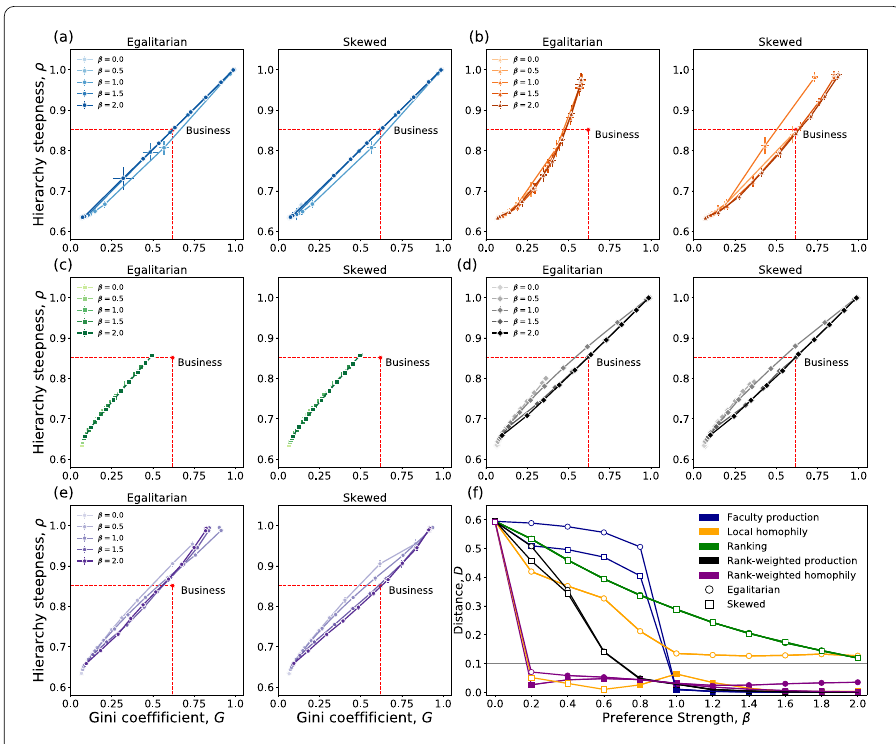
Figure 2 Structural inequalities of five hiring models vs. empirical faculty hiring network of Business departments. ( a )–( e ) Steady-state values of Gini coefficient G and hierarchy steepness ρ , for the five hiring models and two initial conditions for different choices of β (for simplicity, we only show β ∈ { 0.0,0.5,1.0,1.5,2.0 } ). Each line is a parametric plot in which we vary the randomness parameter over 0 ≤ p ≤ 1, and hence all models and choices of β converge to the same point in inequality-space as p → 1. Red dashed lines show the empirical values of G and ρ for the Business faculty hiring network. Results are averaged over 50 simulations, and error bars indicate standard deviations. ( f ) Euclidean distance between an averaged structural inequality ( G , ρ ) obtained from simulation and their pair of empirical values for the Business hiring network. Filled markers represent β values that can reproduce G and ρ with distance D ≤ 0.1; open markers indicate D > 0.1 or a model is not able to reproduce the empirical